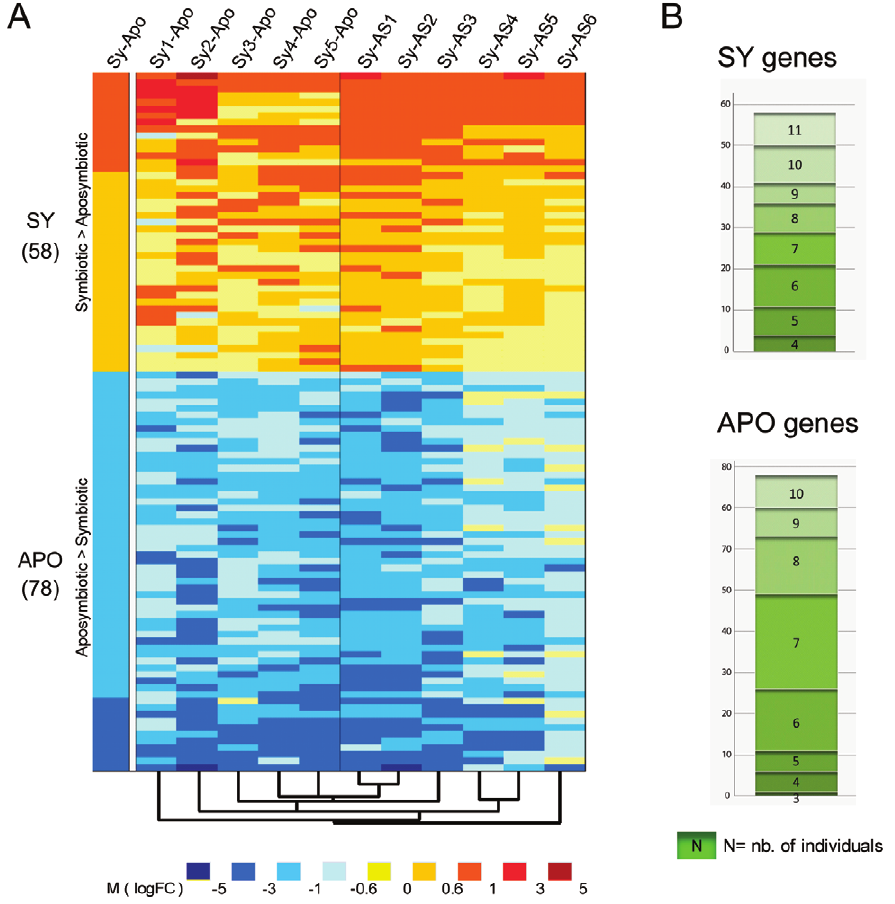
Figure 2. Differentially expressed genes (DEG) between symbiotic and aposymbiotic anemones. A. Heatmap diagram of DEG. Left column (Sy-Apo) represents expression of the 58 up- (SY) and 78 down-regulated (APO) genes (|M| . 0.59, B . 0) identified from the batch comparison of the 5 pooled symbiotic versus the 6 pooled aposymbiotic anemones. The following columns to the right represent expression of the same genes in each individual symbiotic anemone (Sy1–5) compared with the pooled aposymbiotic (-Apo) anemones and in each individual aposymbiotic anemone (AS1–6) compared with the pooled symbiotic (-Sy) anemones. The dendogram underneath the heatmap represents the cluster array tree result performed on the entire result dataset (with Cluster3). The color intensity code representing M value intervals is shown below. B. A given gene can be differentially expressed in the batch analysis (SY or APO) although only differentially expressed in few individual sea anemones. Histogram shows the number of individual anemones (3–11) each gene is differentially expressed in. Top and bottom panels: gene distribution of SY and APO genes, respectively.